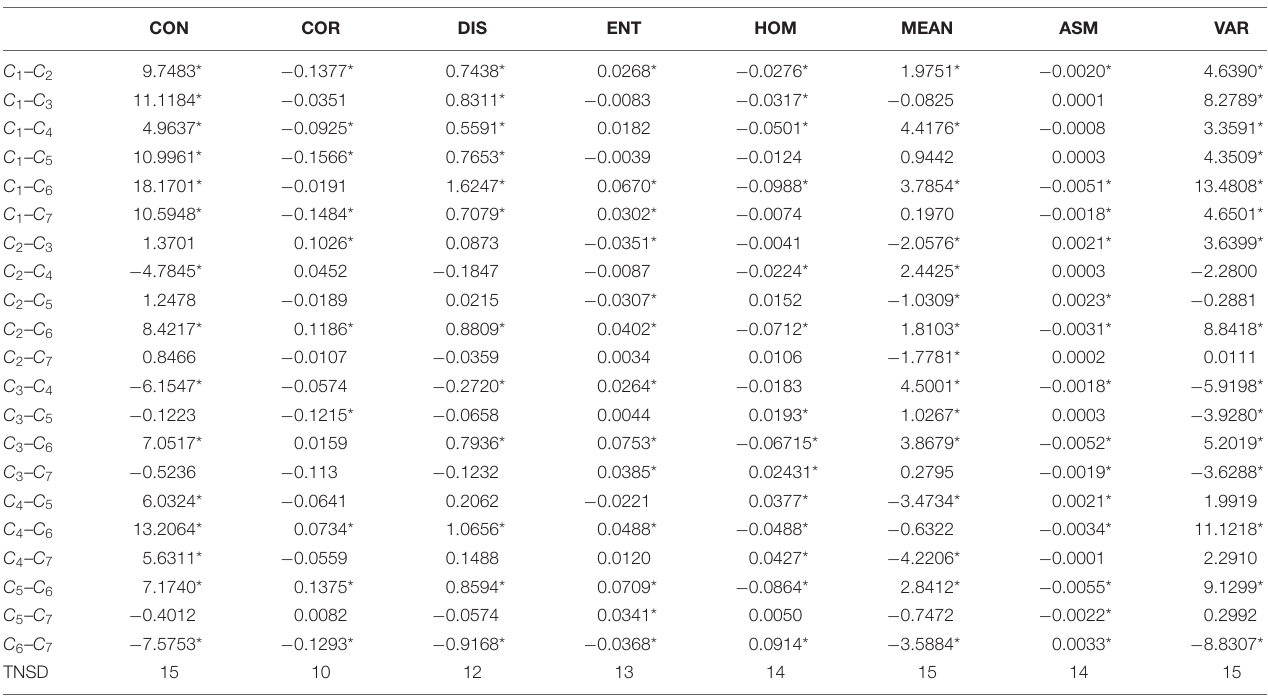
TABLE 6 | Statistical table of Tukey’s HSD post hoc tests.